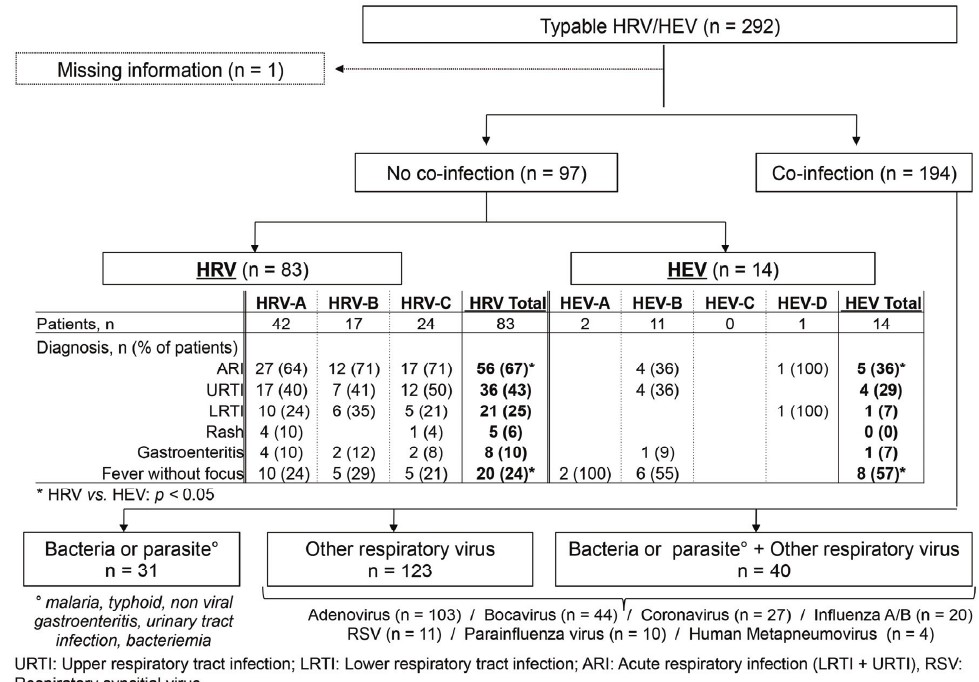
Figure 3. Flowchart of typable human rhinoviruses (HRV) and enteroviruses (HEV) according to presence of co-infection and diagnosis.